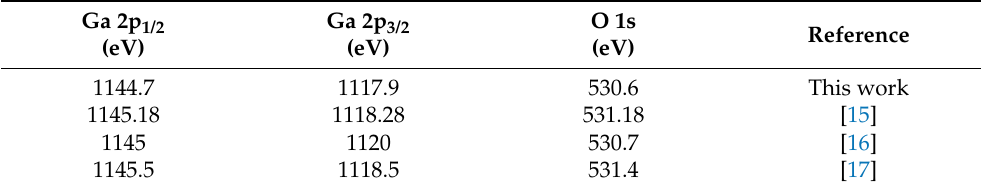
Figure 2. ( a ) The X-ray diffraction (XRD) pattern and ( b ) the X-ray photoelectron spectroscopy (XPS) of the Ga 2 O 3 substrate, of which the scanning electron microscope (SEM) image is shown in ( a ) inset. Table 1. Comparison of the binding energies of Ga 2p 1/2 , Ga 2p 3/2 , and O